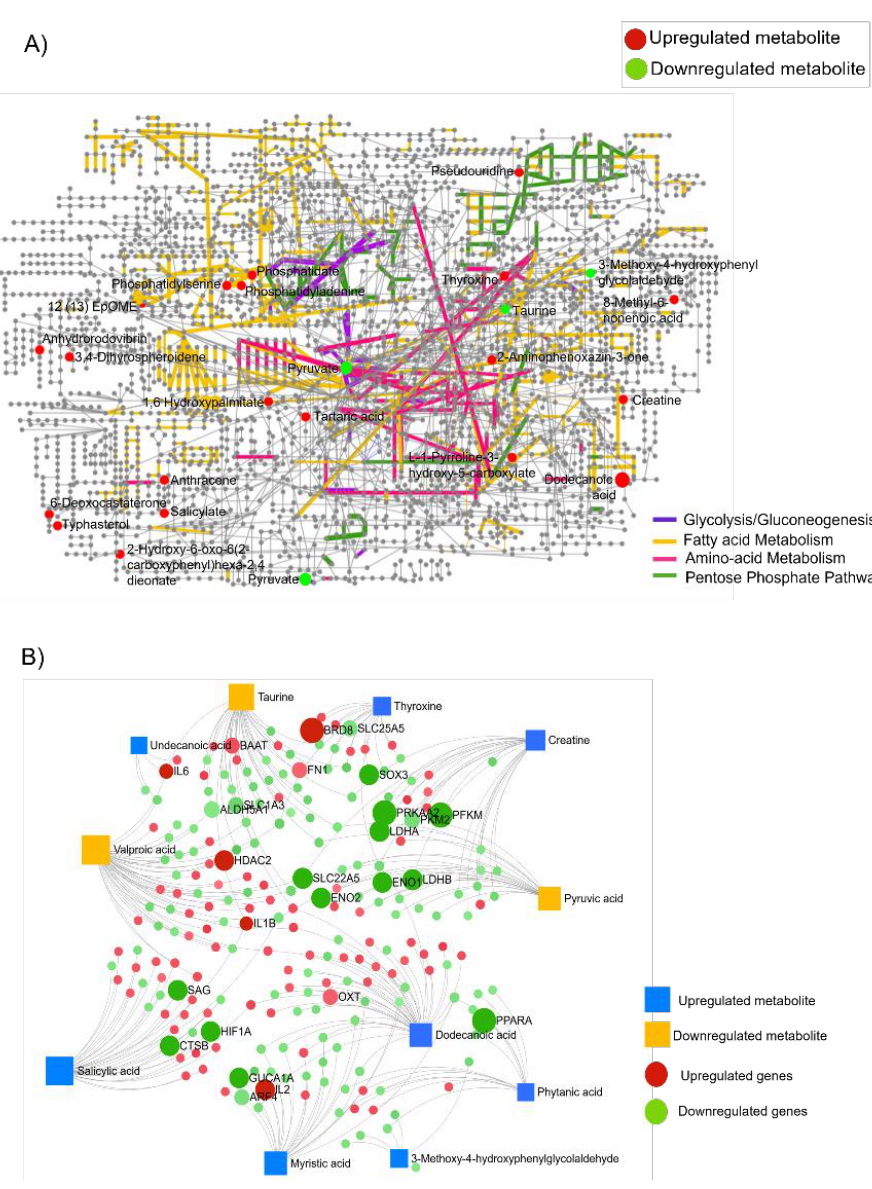
Figure 5. Integrated transcriptomic and metabolome analysis provides unique insights into pathways that are associated with retinoblastoma. ( A ) Differentially accumulated metabolites identified in Rb vitreous were mapped onto the KEGG global metabolome map associated with Rb. The nodes in the figure represent metabolic compounds. Edges are enzymatic transformations. Highlighted nodes represent the differentially accumulated metabolites identified in Rb vitreous. p < 0.05, FC > 2; upregulated (in red), p < 0.05, FC < 2; downregulated (in green). Edges highlighted in violet represent the glycolysis/gluconeogenesis map in Rb. Edges highlighted in yellow represent the fatty acid metabolism-related enzyme map in Rb. Edges in pink represent the amino-acid metabolism map in Rb. Edges in green represent the pentose phosphate pathway enzymes in Rb. ( B ) Integration of transcriptomic and metabolomic interaction network. Circular nodes indicate differentially regulated genes identified from the microarray; (in green as downregulated set: p < 0.05, FC < 2; in red as upregulated set: p < 0.05, FC > 2. Square blue nodes indicate differentially accumulated metabolites from metabolomics analysis ( p < 0.05). Blue square nodes indicate upregulated metabolites (FC > 2), and yellow square nodes indicate downregulated metabolites (FC <